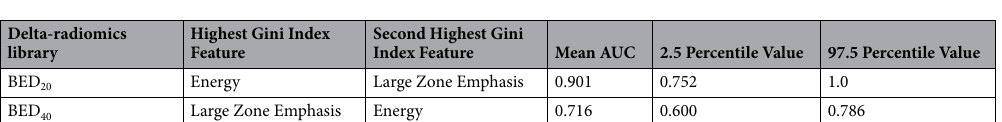
Figure 2. The bolded receive operator characteristic curve in each graph represents the random forest’s estimate obtained during training for ( A ) BED 20 and ( B ) BED 40 . The AUC for the BED 20 delta-radiomics features = 0.920 and the AUC for the BED 40 was = 0.638.